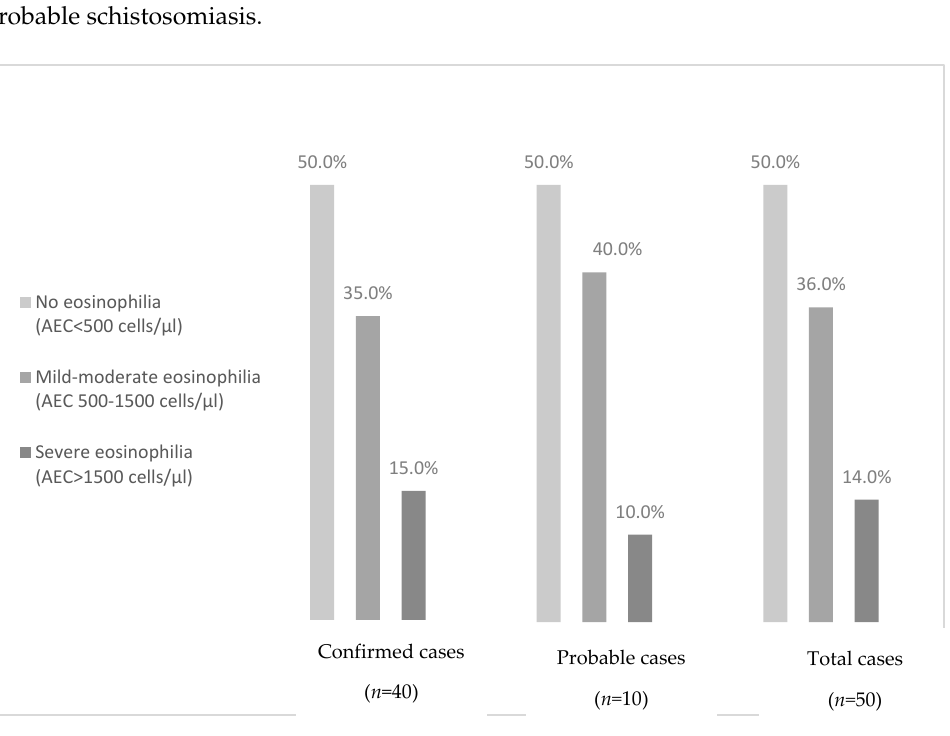
Figure 3. Grades of eosinophilia (by relative frequency) in schistosomiasis cases. The proportion of schistosomiasis cases did not differ significantly r between both strategies (46 cases [11.5%] in group A vs. 4 cases [9.8%], p = 0.733). According to the